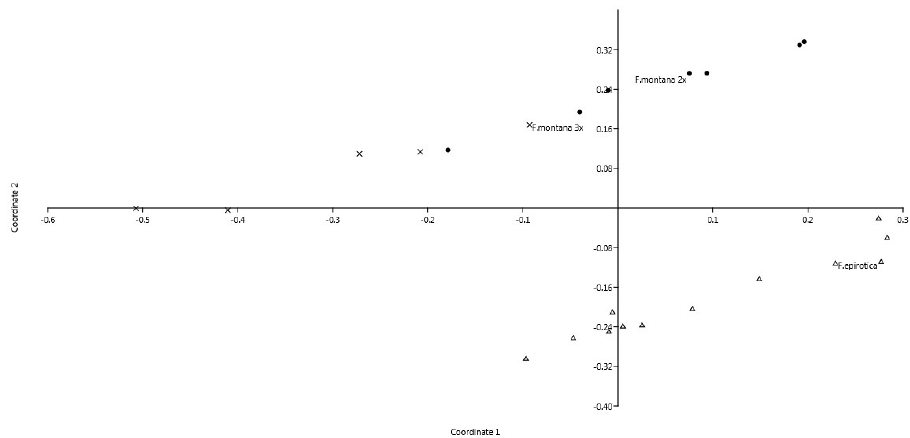
Figure 7. PCoA analysis based on six quantitative karyologial parameters. Triangle depicts F. epirotica , 2n = 2x = 24; dots F. montana , 2n = 2x = 18 and x F. montana , 2n = 3x =